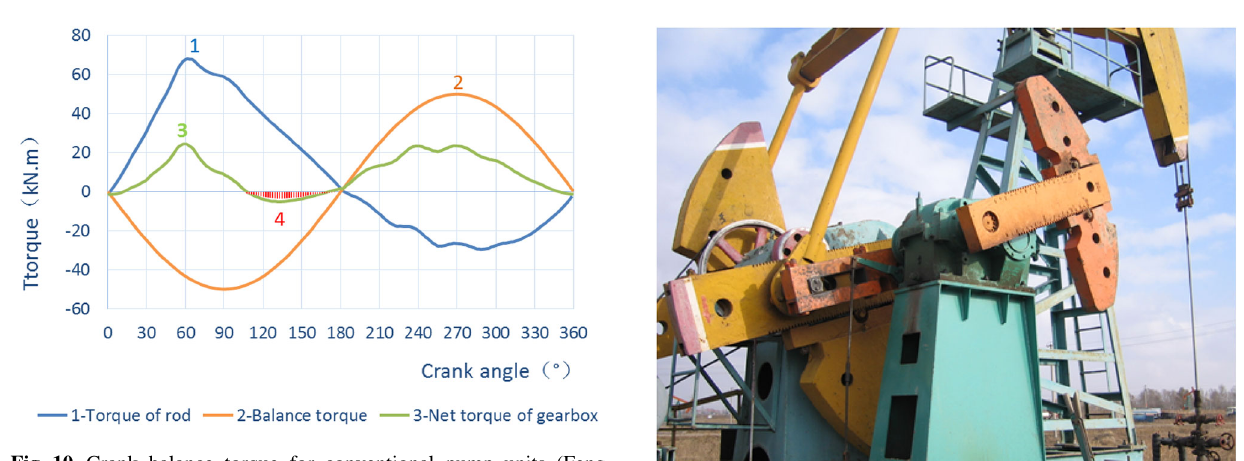
Fig. 10 Crank balance torque for conventional pump units (Feng et al. 2015)